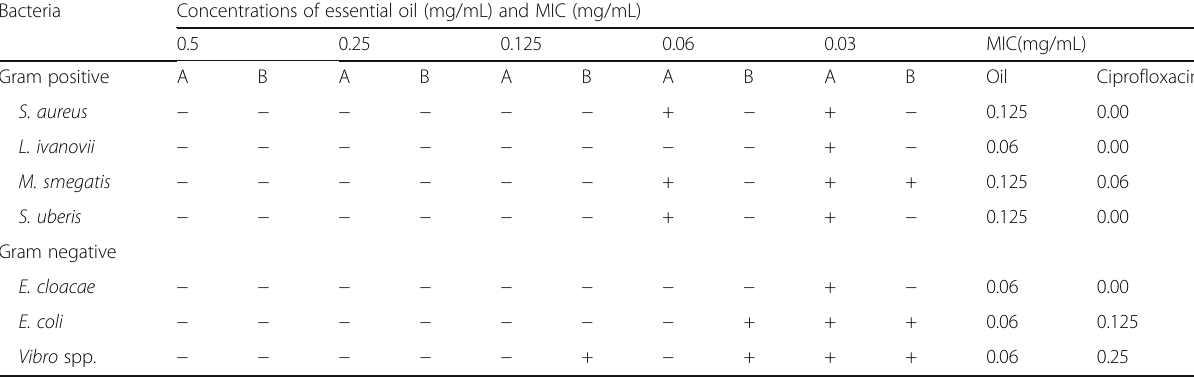
Table 3 Minimum inhibitory concentrations (MIC) of essential oil of T. minuta flower Bacteria Concentrations of essential oil (mg/mL) and MIC (mg/mL)